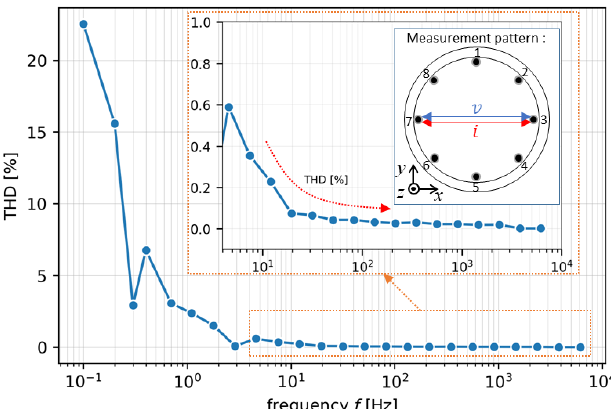
Figure 2. A ten k- th harmonic THD plot in the case of ZnO material at I = 1 mA under the range of f = 0.1~10,000 Hz.